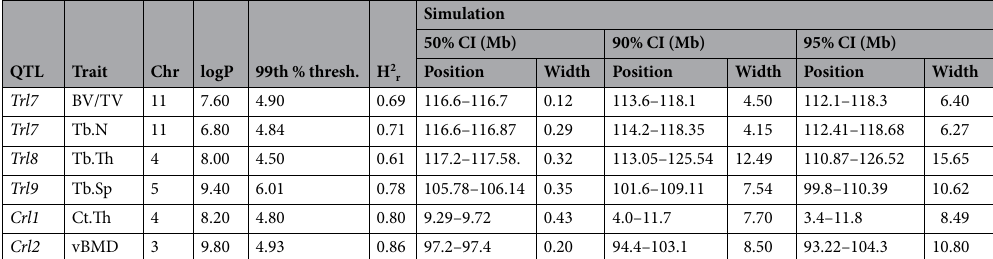
Table 2. Positions of QTLs associated with trabecular and cortical traits. Chr = chromosome; logP = negative 10-base logarithm of P value; Sig = genome-wide significance level; 99th % threshold logP = threshold used to define cut-off for QTL peaks (Fig. 4); H r2 = regional heritability (the proprtion to which the locus explains the phenotypic variability). Positions and widths of the simulation-based 50, 90, and 95% CIs are